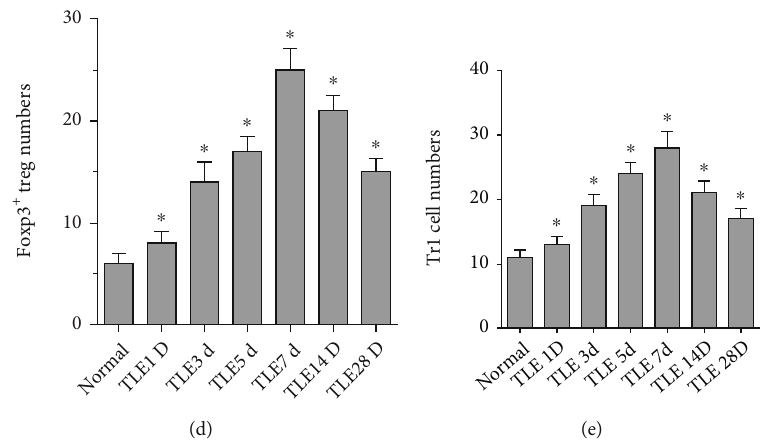
Figure 5: Changes of the numbers of Th17cells, nTregs, and Tr1 cells in the pathogenesis and development of epilepsy. (a) Colocalization of NeuN (red) and IL-17A, Foxp3, and CD49b (green) on D7 after SE were detected by immuno fl uorescent staining, and cell nuclei were counterstained by DAPI. Bar, 20 μ m. (b) Representative images of immunohistochemical staining of IL-17A, Foxp3, and CD49b in the hippocampus. Bar, 50 μ m. (c – e) The numbers of Th17, nTregs, and Tr1 cells were measured on D1, D3, D5, D7, D14, and D28 after SE, respectively. The data were represented as mean ± SD . ∗ P < 0 : 05 vs. the normal group.